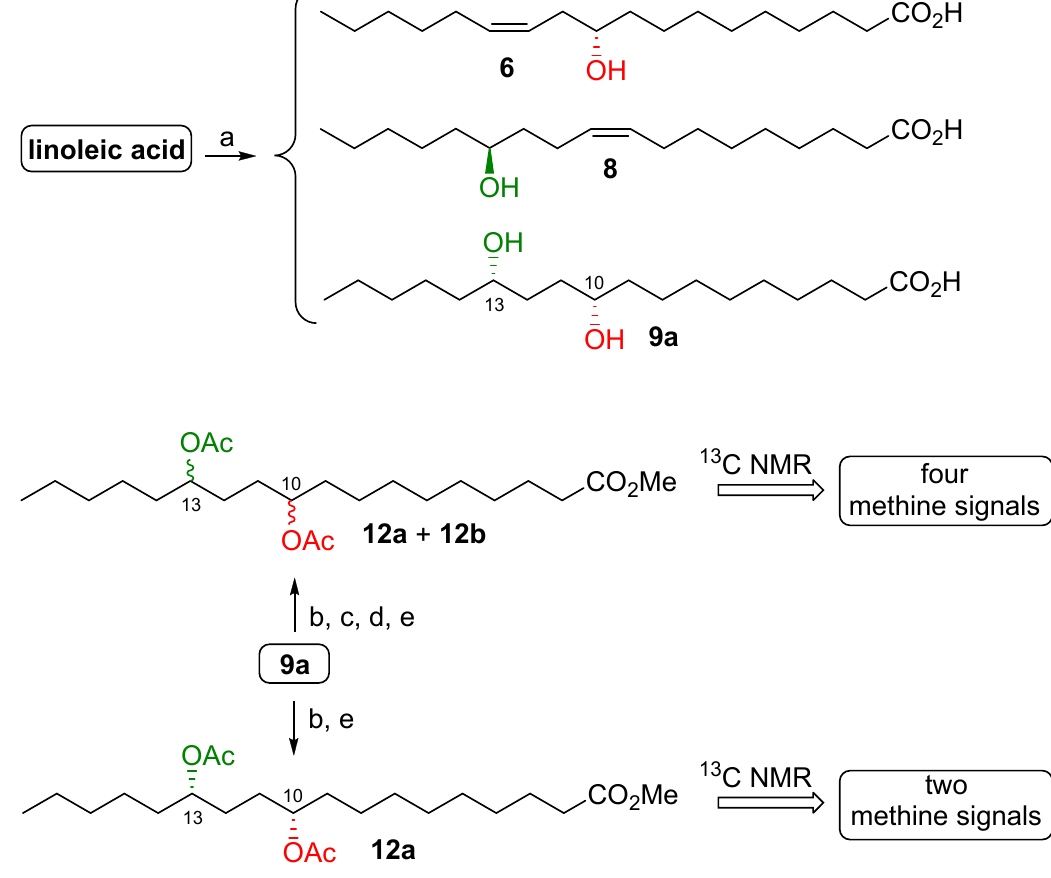
Figure 4. Biotransformation of linoleic acid ( 2 ) by Lactobacillus acidophilus (ATCC SD5212) and demonstration that diol 9a is produced as a single diastereoisomeric form. Reagents and conditions: ( a ) Fermentation with Lactobacillus acidophilus (ATCC SD5212); ( b ) CH 2 N 2 , Et 2 O, 0 °C; ( c ) DMSO, ClCOOCl, Et 3 N, CH 2 Cl 2 , − 70 °C; ( d ) NaBH 4 , MeOH, 0 °C then HCl aq. (3% w / v ); ( e ) Ac 2 O, Py, DMAP cat.,